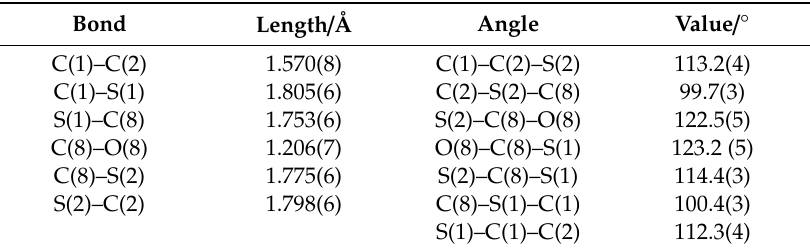
Figure 1. Two views of the molecular structure of 1 with numbering scheme (ORTEP probability ellipsoids at 50%). Table 1. Selected bond lengths and angles.